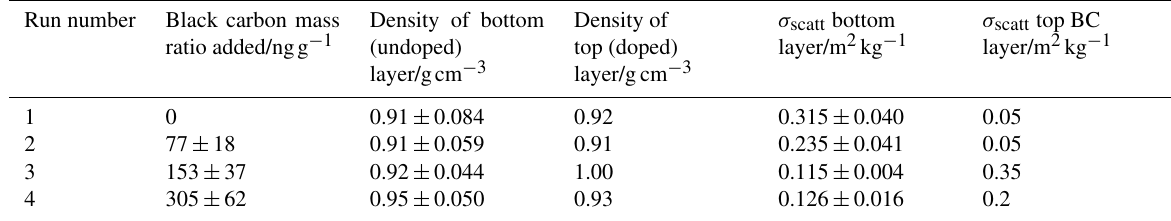
Table 1. Optical and physical properties of sea ice for each run, including the mass ratio of black carbon added to the top layer of ice, density of ice and scattering cross section ( σ scatt ) of both the top and bottom layers of the ice. The uncertainty in sea ice density is 1 standard deviation of the average of measurements taken from the core profile. Uncertainty is not provided for the density of the top layer as this is the average of only two measurements, although the uncertainty is likely to be similar to that of the lower layer. The mass ratio of black carbon added to the surface layer is also shown. The uncertainty in the black carbon mass ratio is the uncertainty in the gravimetric method used for determining the mass ratio, as described in Sect.